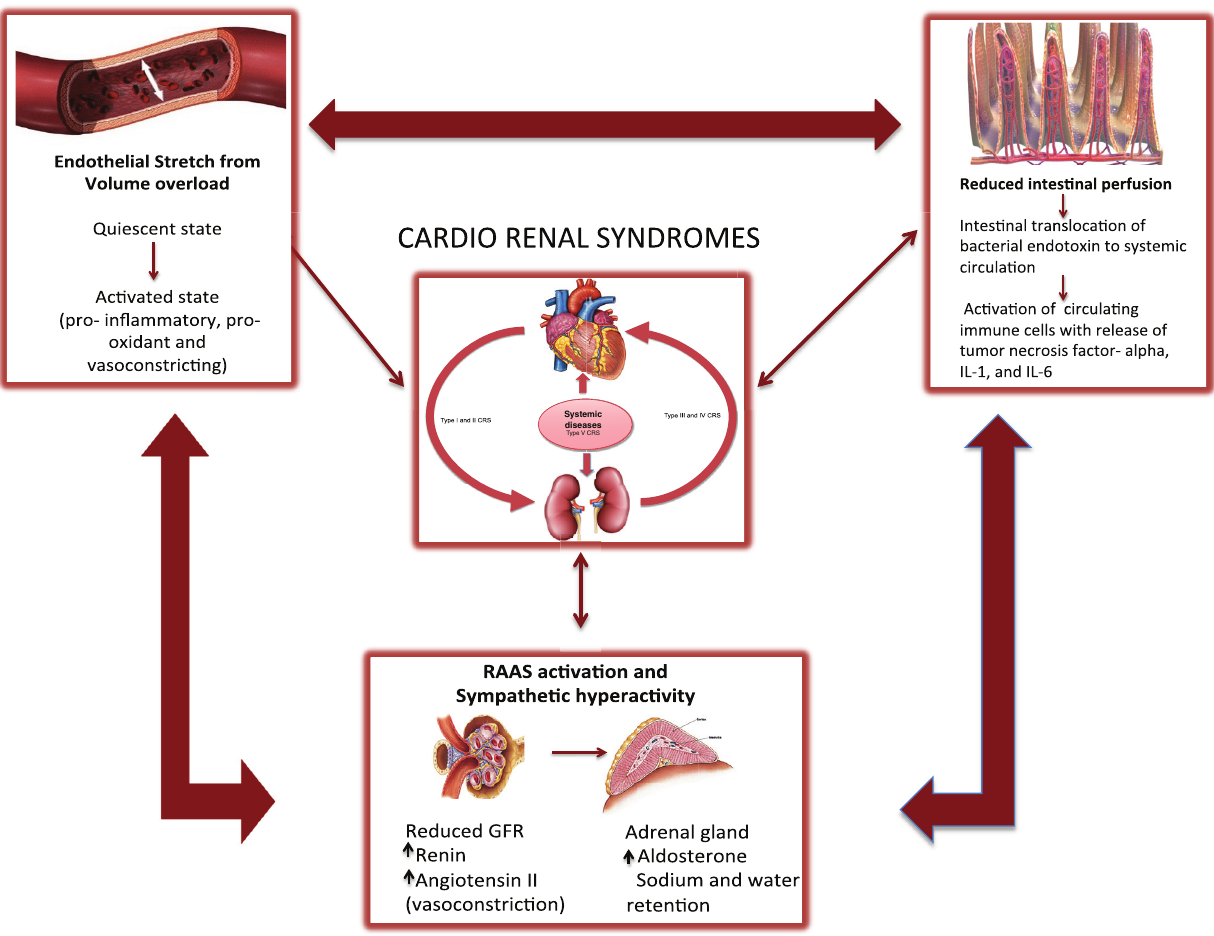
Figure 1. Pathophysiological interactions contributing to cardio-renal syndrome. Figure illustrates how RAAS activation, intestinal hypoperfusion, abnormal endothelial activation, and release of pro-inflammatory cytokines contribute to the development of CRS. CRS, cardio-renal syndrome; RAAS, renin–angiotensin–aldosterone